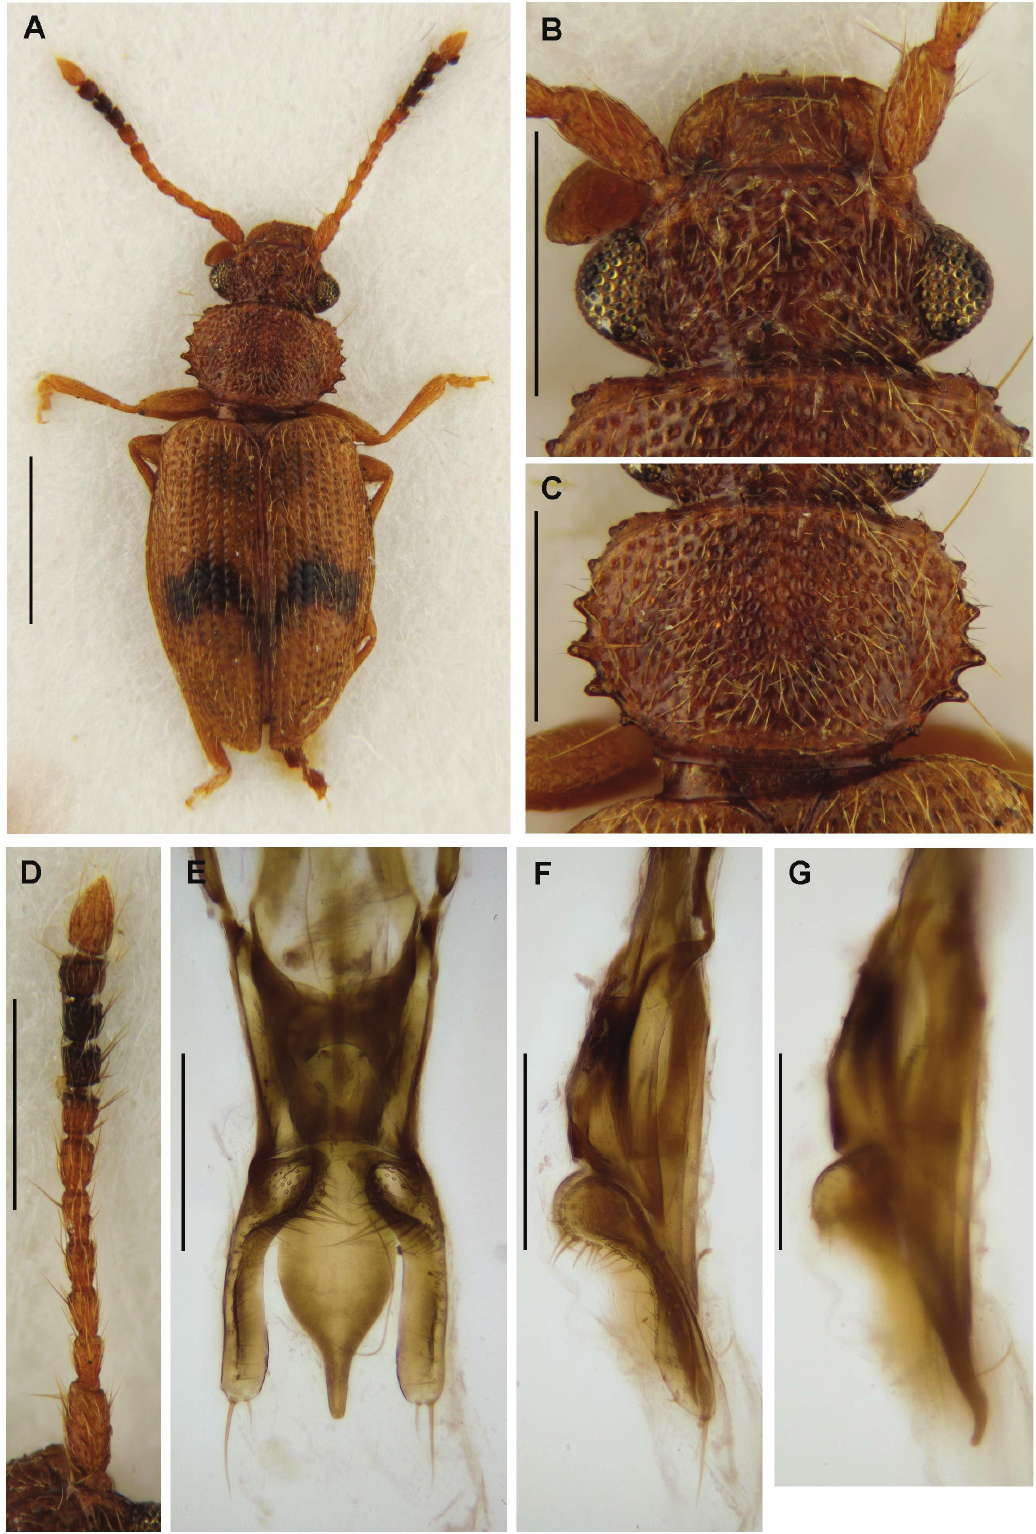
Fig. 2. Psammoecus nyakabuyensis sp. nov., holotype. A . Habitus. B . Head. C . Pronotum. D . Right antenna. E . Aedeagus, ventral view. F . Paramere, lateral view. G . Median lobe, lateral view. Scale lines: A = 1.0 mm, B–D = 0.5 mm, E–G = 0.2